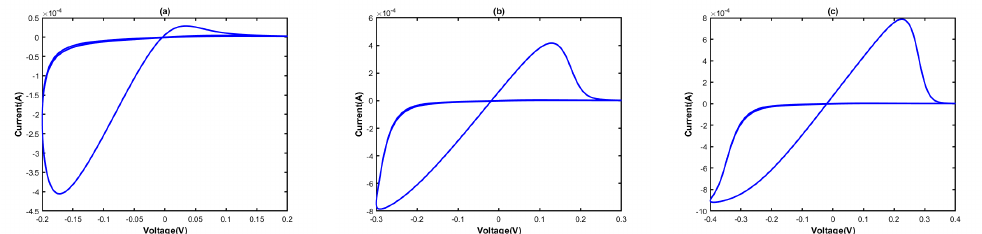
Figure 12. Hysteresis loops for different amplitudes of input voltages for 45 nm: ( a ) 200 mV, ( b ) 300 mV, and ( c ) 400 mV.